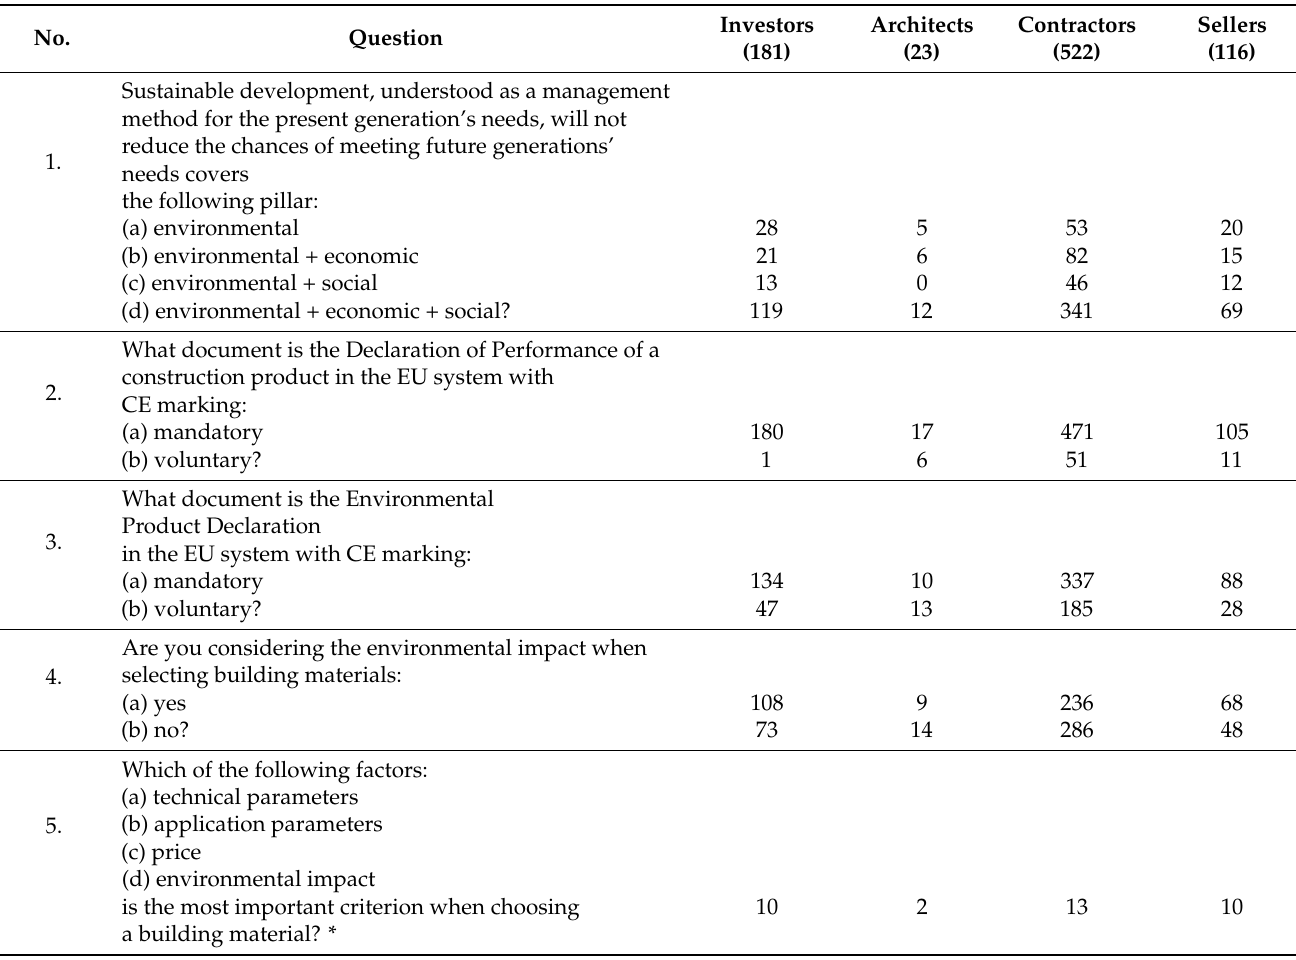
Table 2. Obtained survey results (questions and answers) in the questionnaire in individual surveyed professional groups.